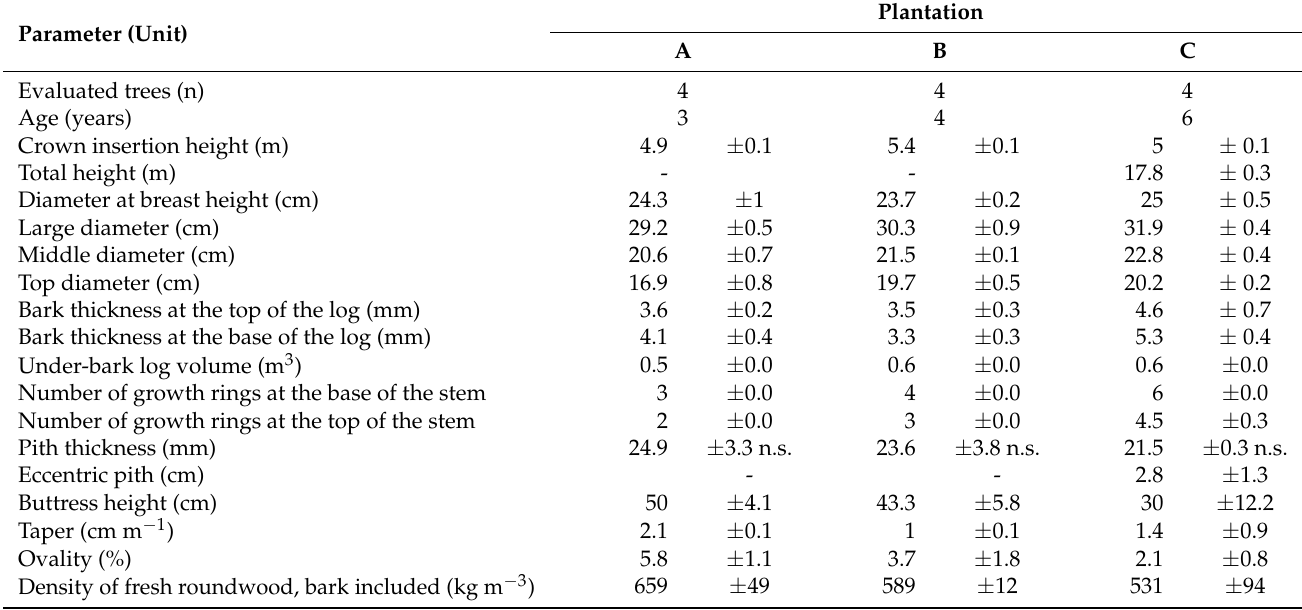
Table 2. Paulownia roundwood characteristics in three plantations (A, B, and C) in Emilia-Romagna, northern Italy. Values are reported as mean ± s.e. “n.s.” next a value indicates no significant difference among values measured in the three plantations. When no letters are reported in the cells next to the numbers, it means that no statistical comparison was performed.